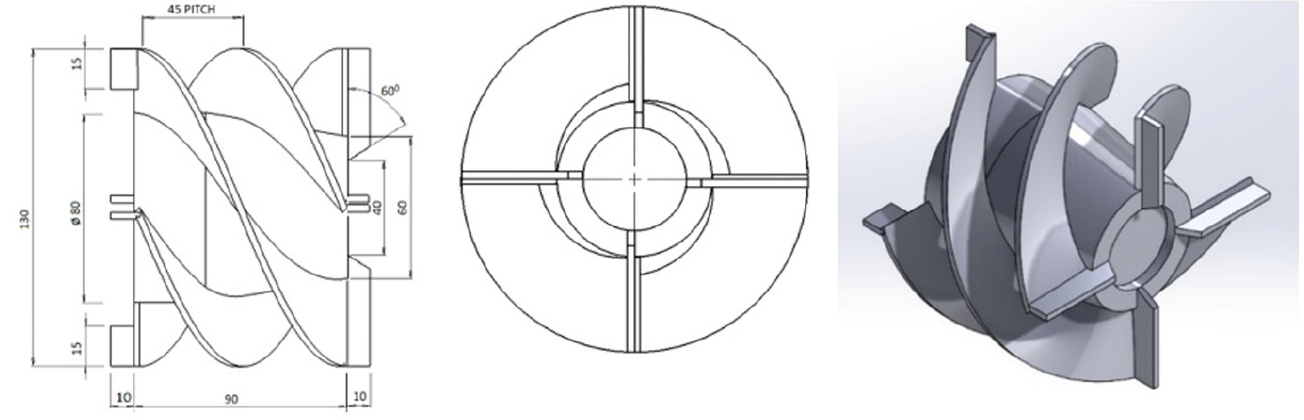
Figure 15. The geometric parameters and isometric view of the rotor with four equidistant blades and pitch length 45 mm.